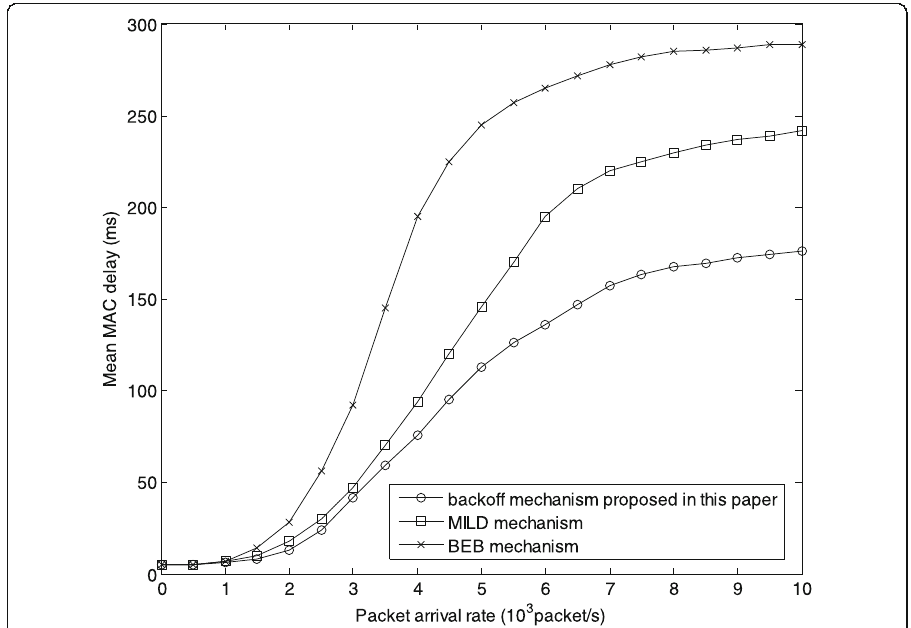
Fig. 8 Mean MAC delay in different backoff mechanisms with different packet arrival rates